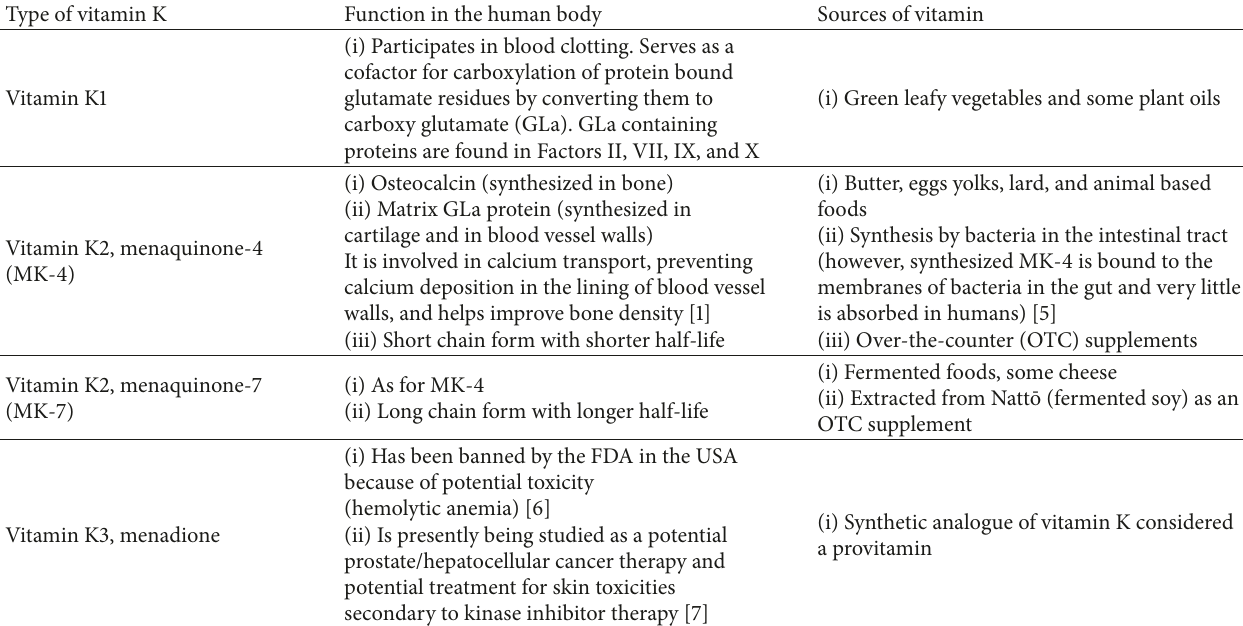
Table 1: Vitamin K types, functions, and sources.